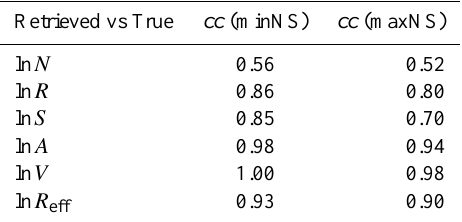
Table 3. Model validation: Correlation coefficients, cc , describing the linear correlation between all accepted (“good”) and the asso- ciated correct aerosol properties. Given the large number of mea- surements ( ≈ 230) these correlation coefficients are all significant at p < 0.05% (Taylor, 1939, Table